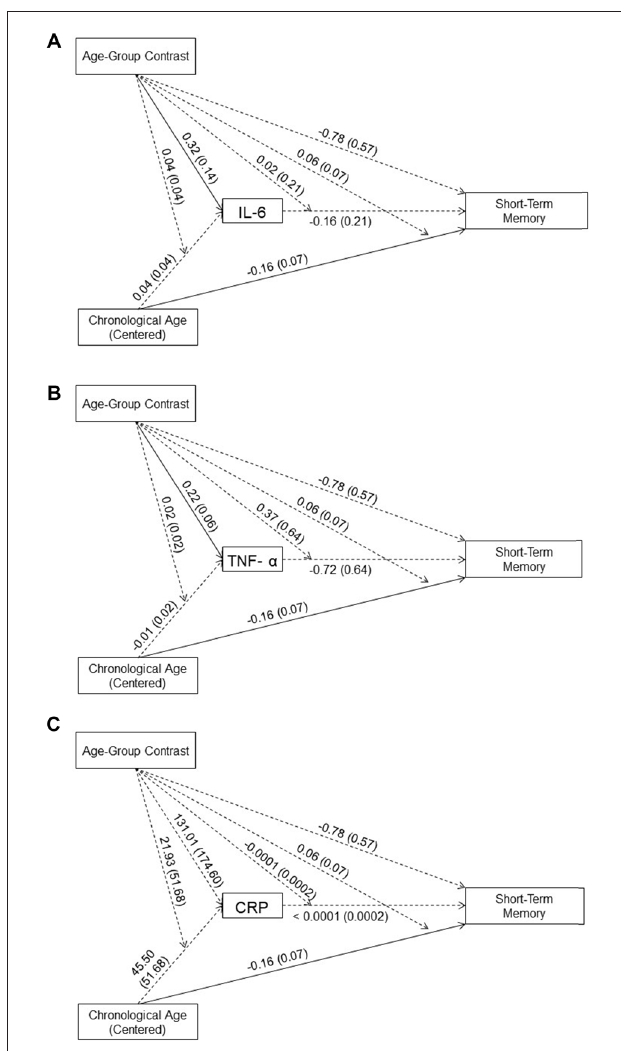
FIGURE 2 | Effects ( B ( SE )) of chronological age (centered), age-group contrast, and IL-6 (A) , TNF- α (B) , and CRP (C) , and their interactions on short-term memory. To improve readability, separate figures show the results from the three systemic inflammation biomarkers while all variables were considered in a single model. Solid lines indicate significance at p <